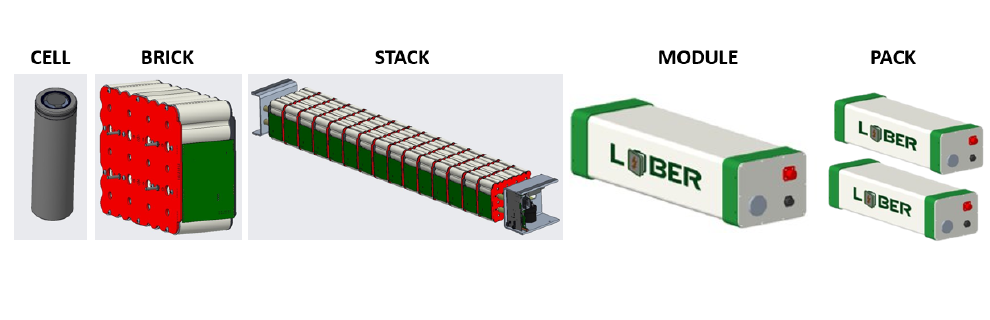
Figure 1. A scheme of the LiBER modular